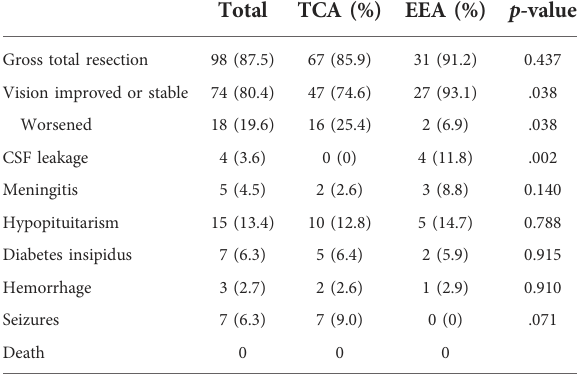
TABLE 2 Postoperative outcomes and